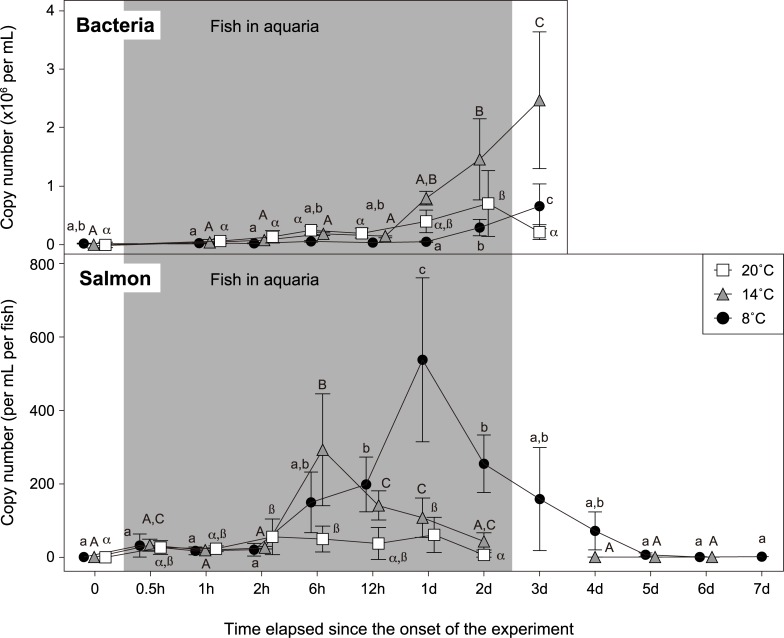
Temporal changes in chum salmon eDNA (lower panel; per mL water sample per fish) and bacterial gene amounts (upper panel; per mL water sample) in aquaria at various water temperatures.Samples at t = 0 were obtained before fish introduction into aquaria. Juvenile chum salmon was in aquaria during the shaded period. Statistical significances were presented with different characters of small, capital and Greek alphabets for 8, 14 and 20°C, respectively (P<0.05). h and d indicate hours and days, respectively.